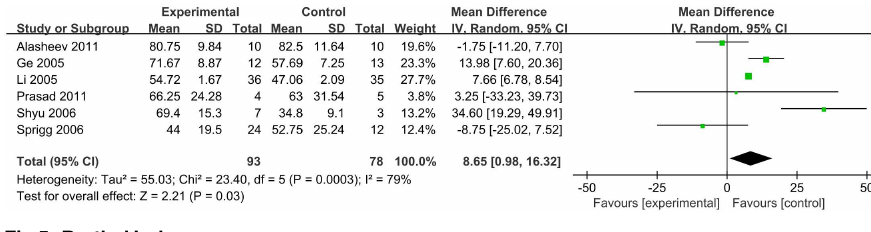
Fig 5. Barthel Index scores.